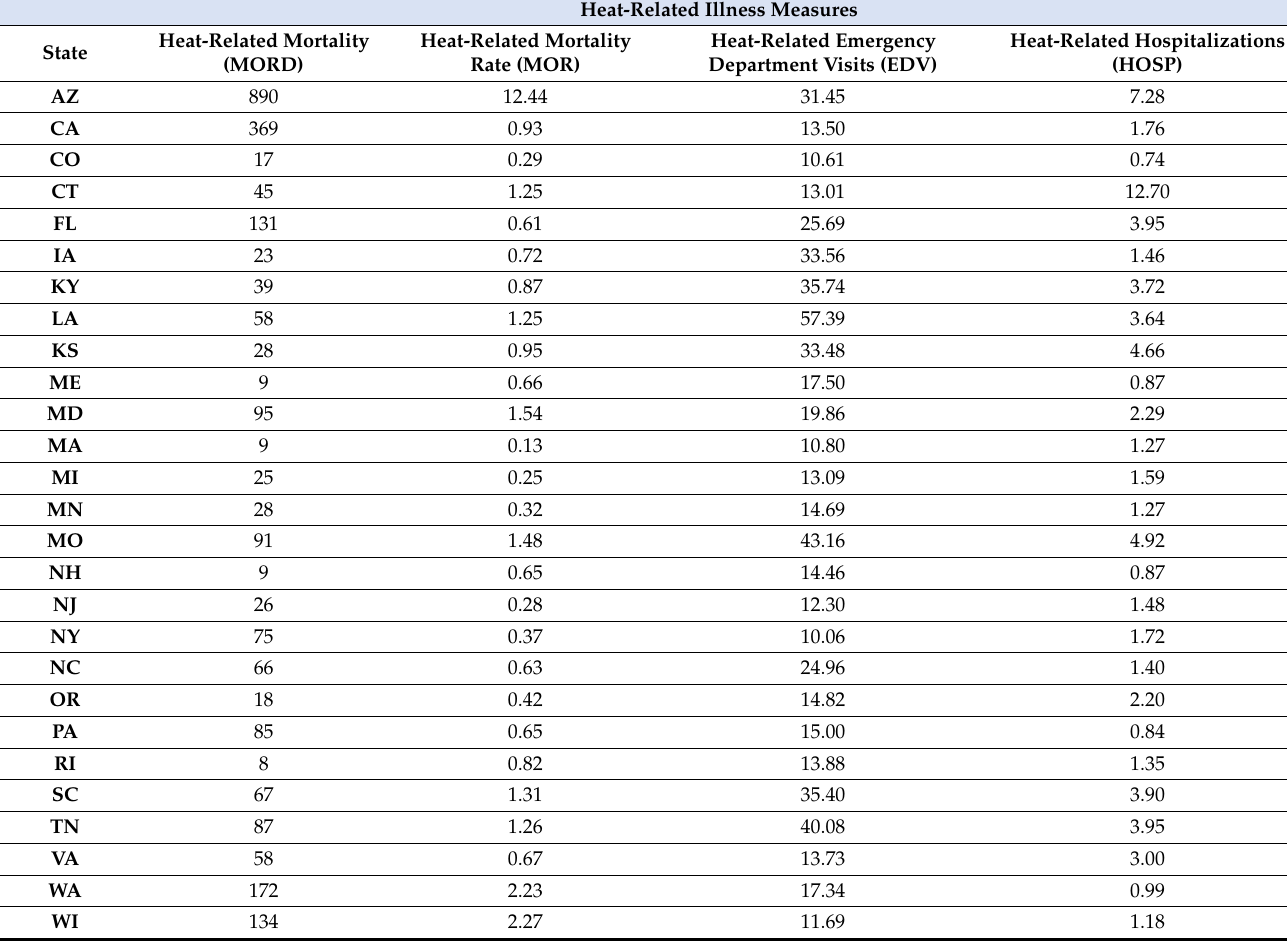
Table 4. Heat-related illness (HRI)